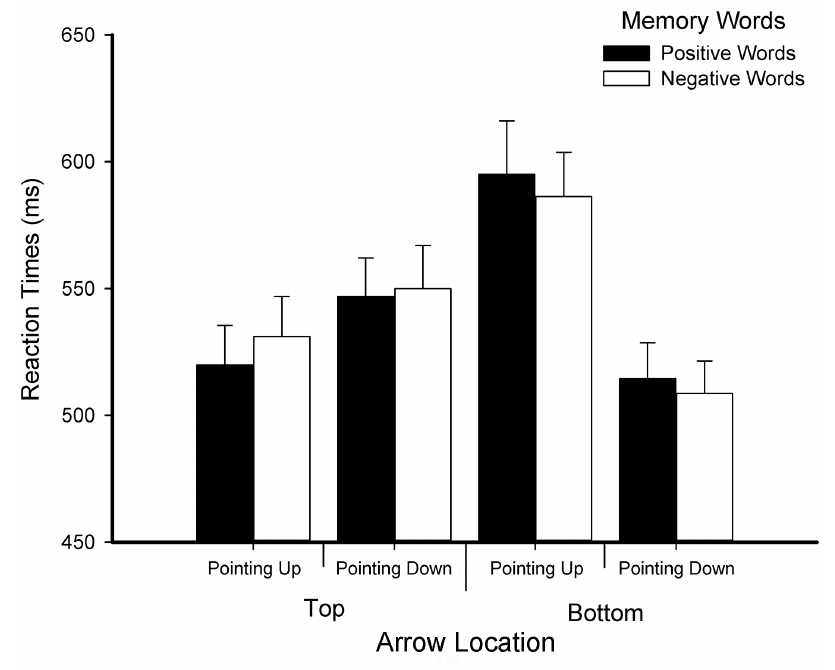
Figure 6. Reaction times for direction discrimination task in Experiment 2.